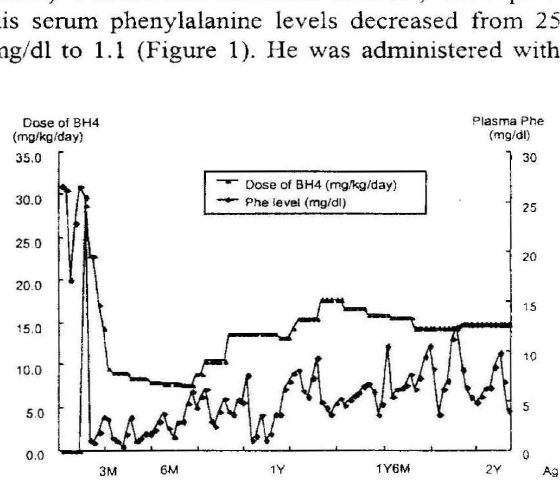
Table 2. Levels of serum pteridines (10 mg/kg BH4)